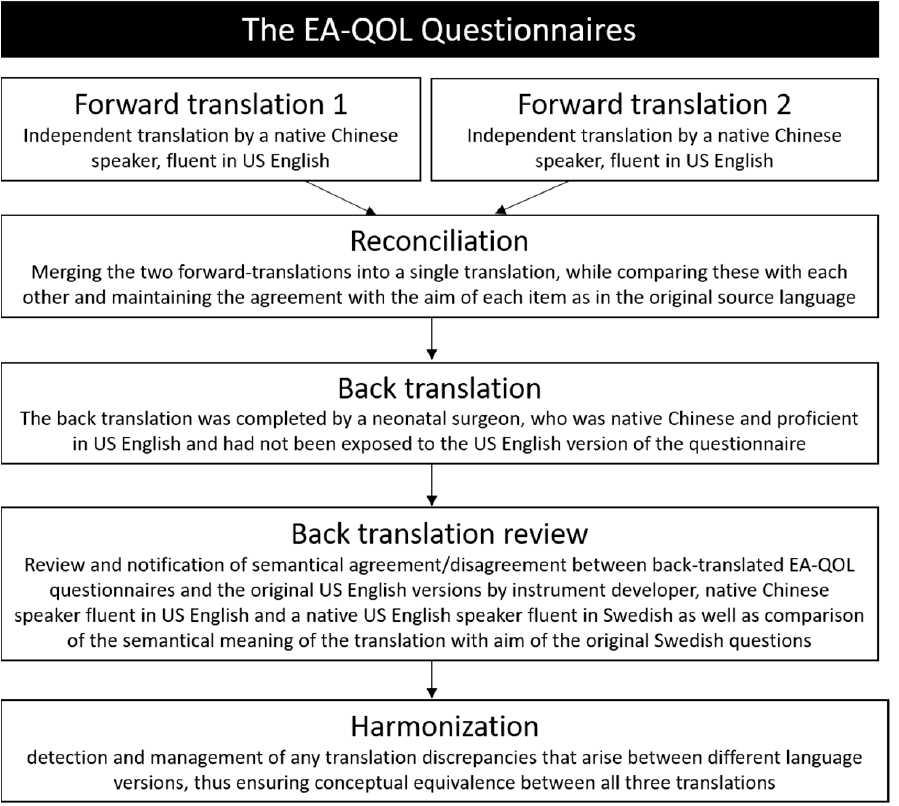
Figure 2. Translation procedure.